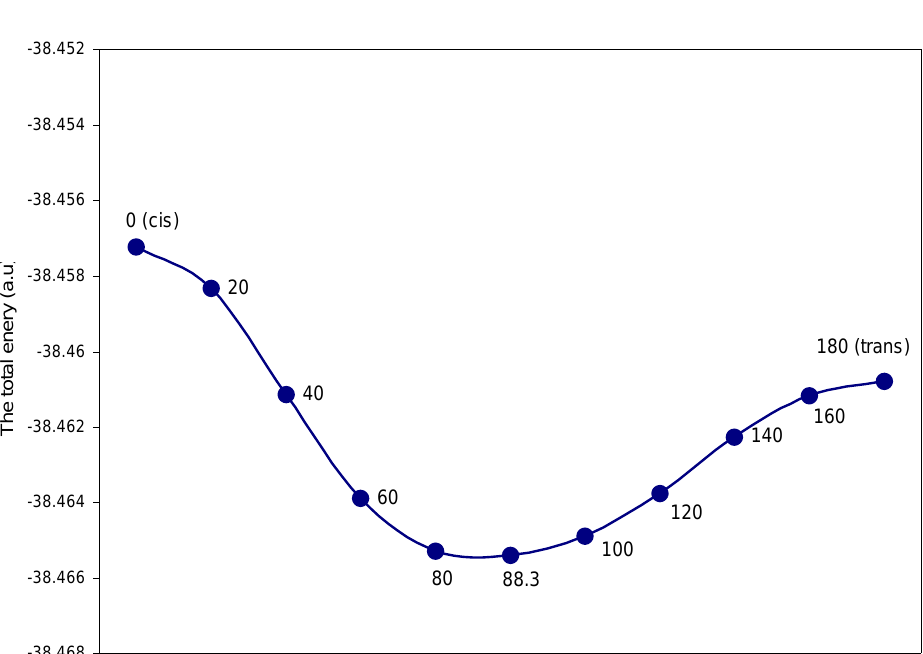
Figure 2. Plot of total energy of hydrogen peroxide molecule as a function of torsional